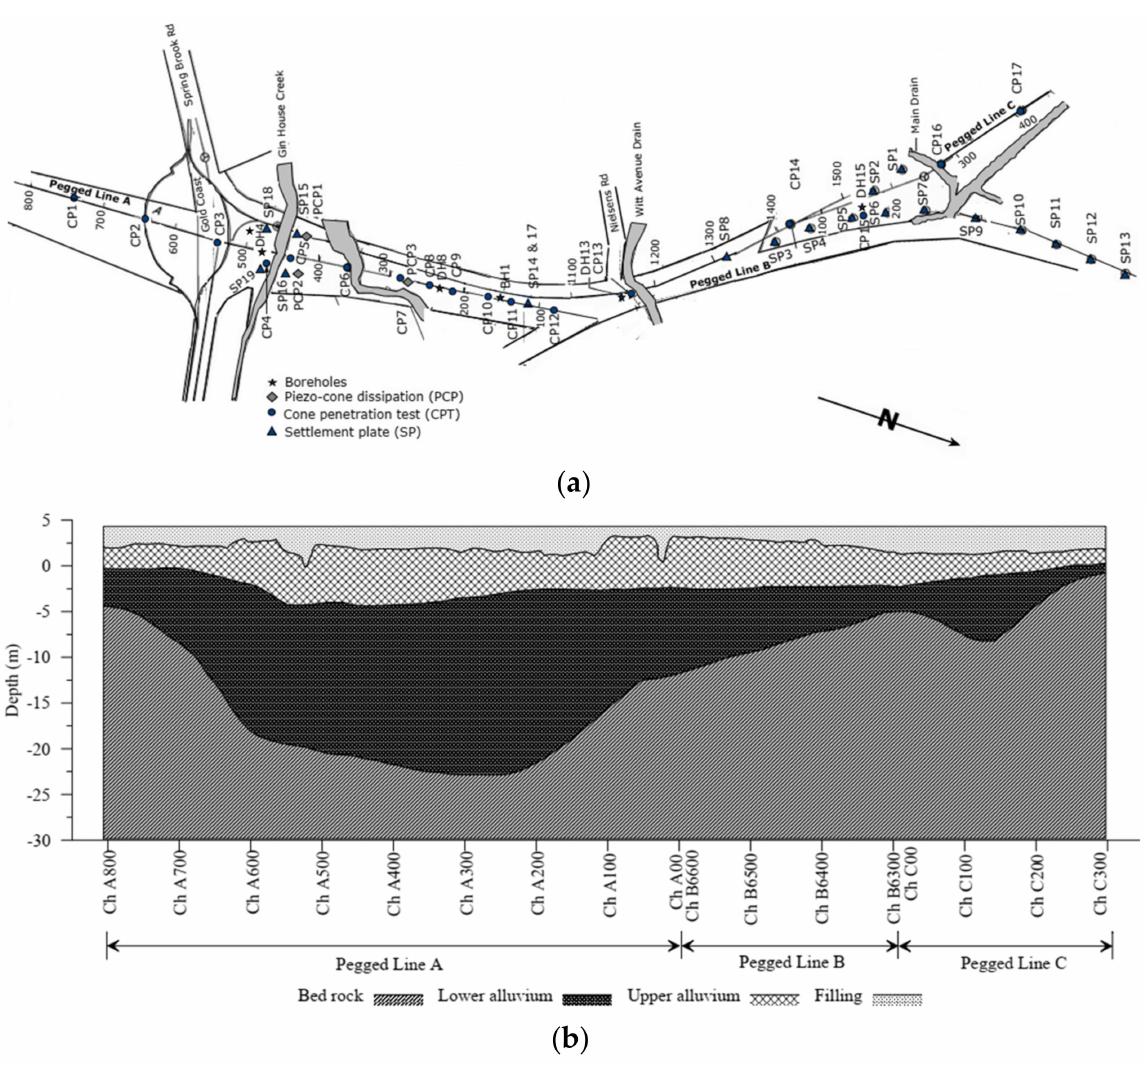
Figure 2. The Nerang Broadbeach Roadway embankment’s ( a ) site plan and ( b ) cross-sections. The bedrock is the lowest level, which consists of the greywacke and the argillite bedrock of the Neranleigh–Fernvale